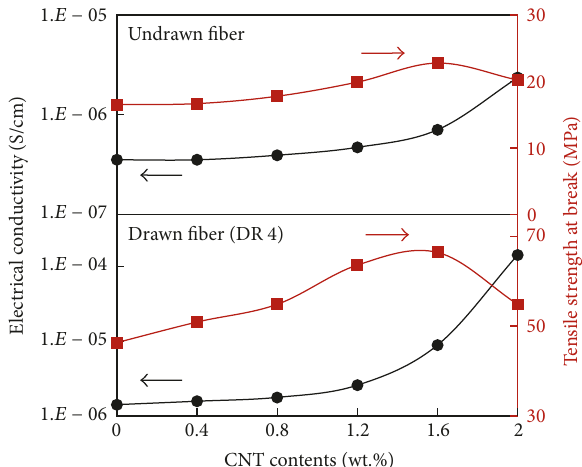
Figure 5: Electrical conductivity (𝜎) and tensile strength of undrawn and drawn LLDPE fiber as a function of CNTs content for a draw ratio of